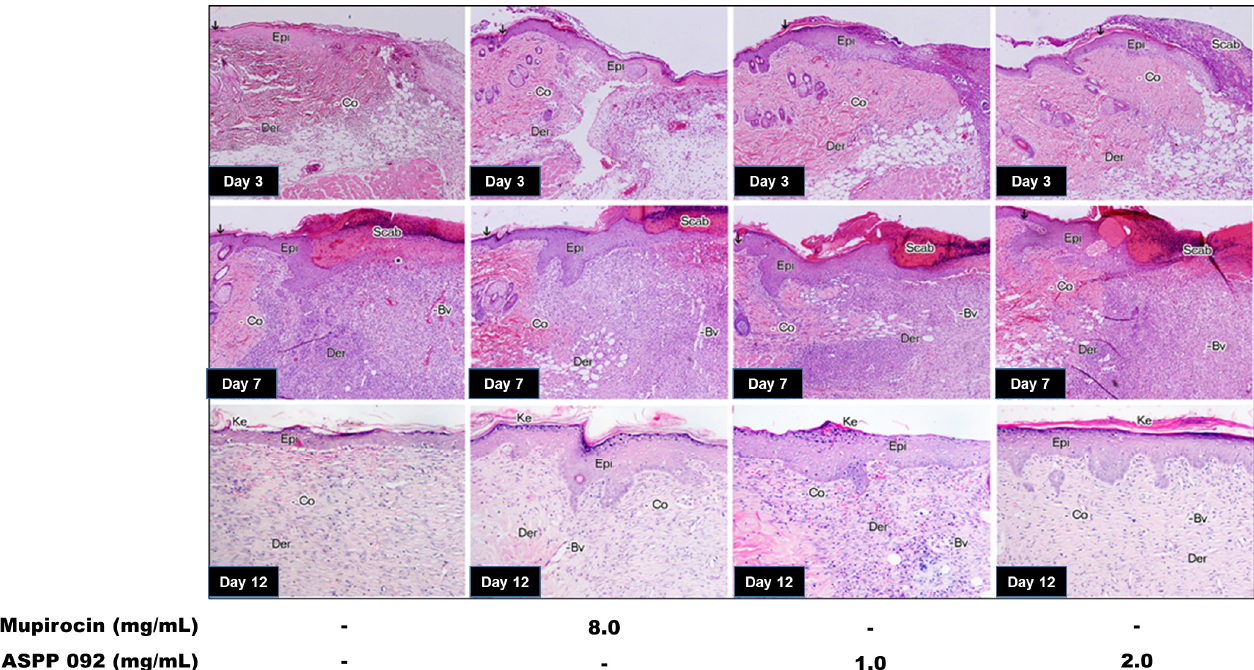
Figure 4. Histopathological observations in the wounds treated with ASPP 092. The experimentally induced wounds were treated with either mupirocin or ASPP 092 at concentrations of 1 mg/mL and 2 mg/mL. A vehicle control group was also maintained. Histopathology sections of the wounds stained with hematoxylin and eosin (H&E) at different time points, including days 3, 7, and 12, were conducted and represented (arrow, wound margin; Bv, blood vessel; Co, collagen fibers; Der, dermis; Epi, epidermis; Ke, keratin; *, inflammatory cells; ×100).